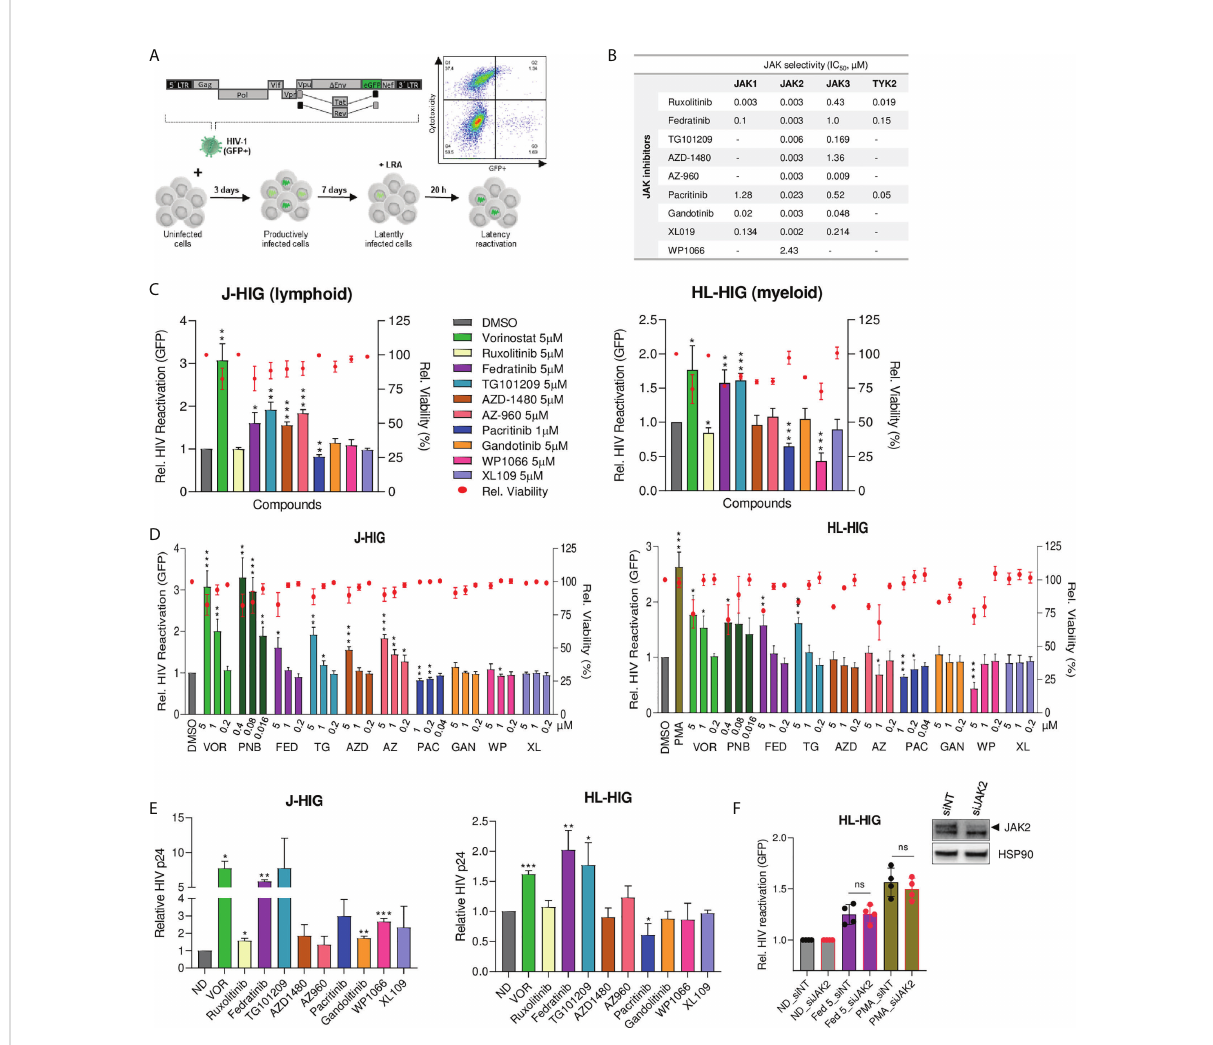
FIGURE 1 Identi fi cation of speci fi c JAK2 inhibitors as latency reversing or latency promoting agents in non-clonal cellular models of HIV-1 latency. (A) Generation of non-clonal models of HIV-1 latency for identifying new latency reversal agents (LRA) by fl ow cytometry. Latently infected models of HIV-1 latency were generated by infecting Jurkat (J-HIG) and HL-60 (HL-HIG) cell lines with the envelope-de fi cient HIV-1 NL4-3 clone (HIG) encoding GFP. Viral reactivation was measured as the proportion of GFP+ cells 20 hours post incubation with compounds. (B) Janus kinase (JAK) selectivity by JAK inhibitors (JAKi) included in the LRA screening. Selectivity refers to 50% inhibitory concentrations (IC 50 ) of corresponding enzymatic activities measured in cell free assays. (C) HIV-1 latency reactivation capacity of JAKi in J-HIG (left panel) and HL-HIG (right panel) models. Bar plots represent relative HIV-1 reactivation and red dots represent cell viability of treatment conditions normalized to the untreated control (DMSO). (D) Expanded screening of JAK2 speci fi c inhibitors in J-HIG (left panel) and HL-HIG (right panel) models. Cells were treated with compounds at the indicated concentrations, as in (C) . (E) Viral protein production in the J-HIG (left panel) and HL-HIG (right panel) models measured by quantifying HIV-1 CAp24 antigen production 48 h post treatment with indicated compounds using VIP-SPOT assay. (F) Effect of JAK2 siRNA knockdown on latency reactivation capacity of LRAs. JAK2 knockdown was con fi rmed by western blot. Bar plots represent relative HIV-1 reactivation of siRNA JAK2 (siJAK2) and non-targeting (siNT) cells, treated or not with fedratinib at 5 µM or PMA at 100 ng/ml. Data are expressed as mean ± SD of at least three independent experiments. ND, no drug; VOR, vorinostat. ∗ p<0.05; ∗∗ p<0.01; ∗∗∗ p<0.001. not signi fi cant (ns) for